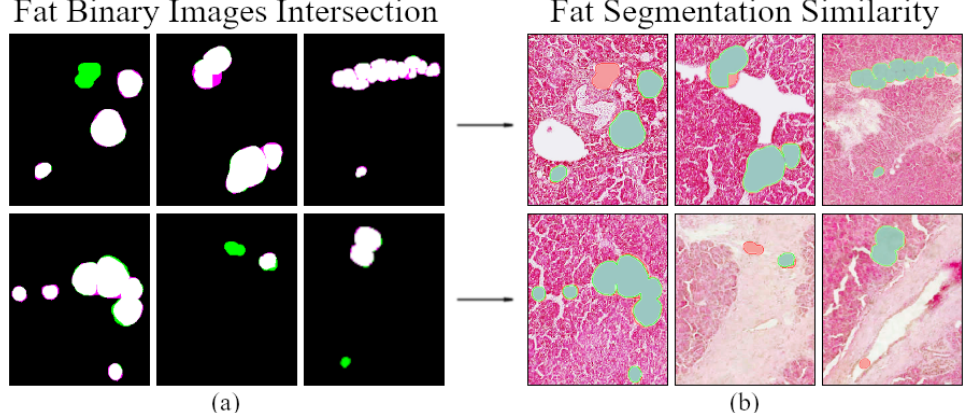
Figure 7. Visual representation of fat segmentation similarity results: ( a ) white → TP fat pixels, resulting from the intersection of logical ‘1’ values in ground truth and computed segmentation images, green → FP steatosis structures included by the automated approach and not by manual annotation and magenta → FN fat pixels included by annotation and not by the computational method; ( b ) green → common areas of fat accumulation between the two binary images and red → inaccurate or failed inclusions of fat structures by the methodological